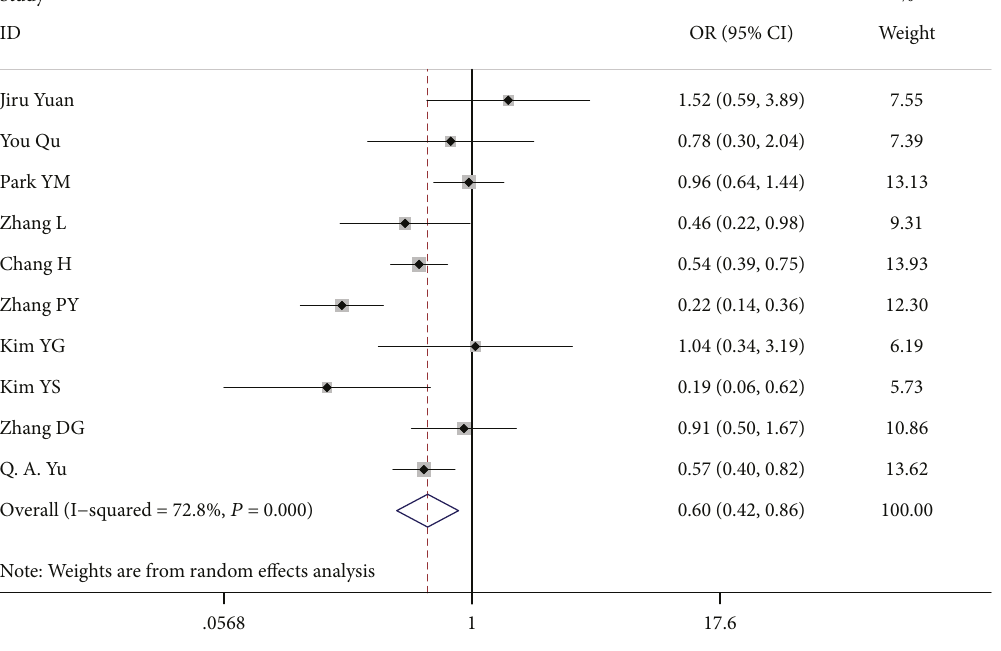
Figure 6: Forest plot for metastasis according to multifocality.